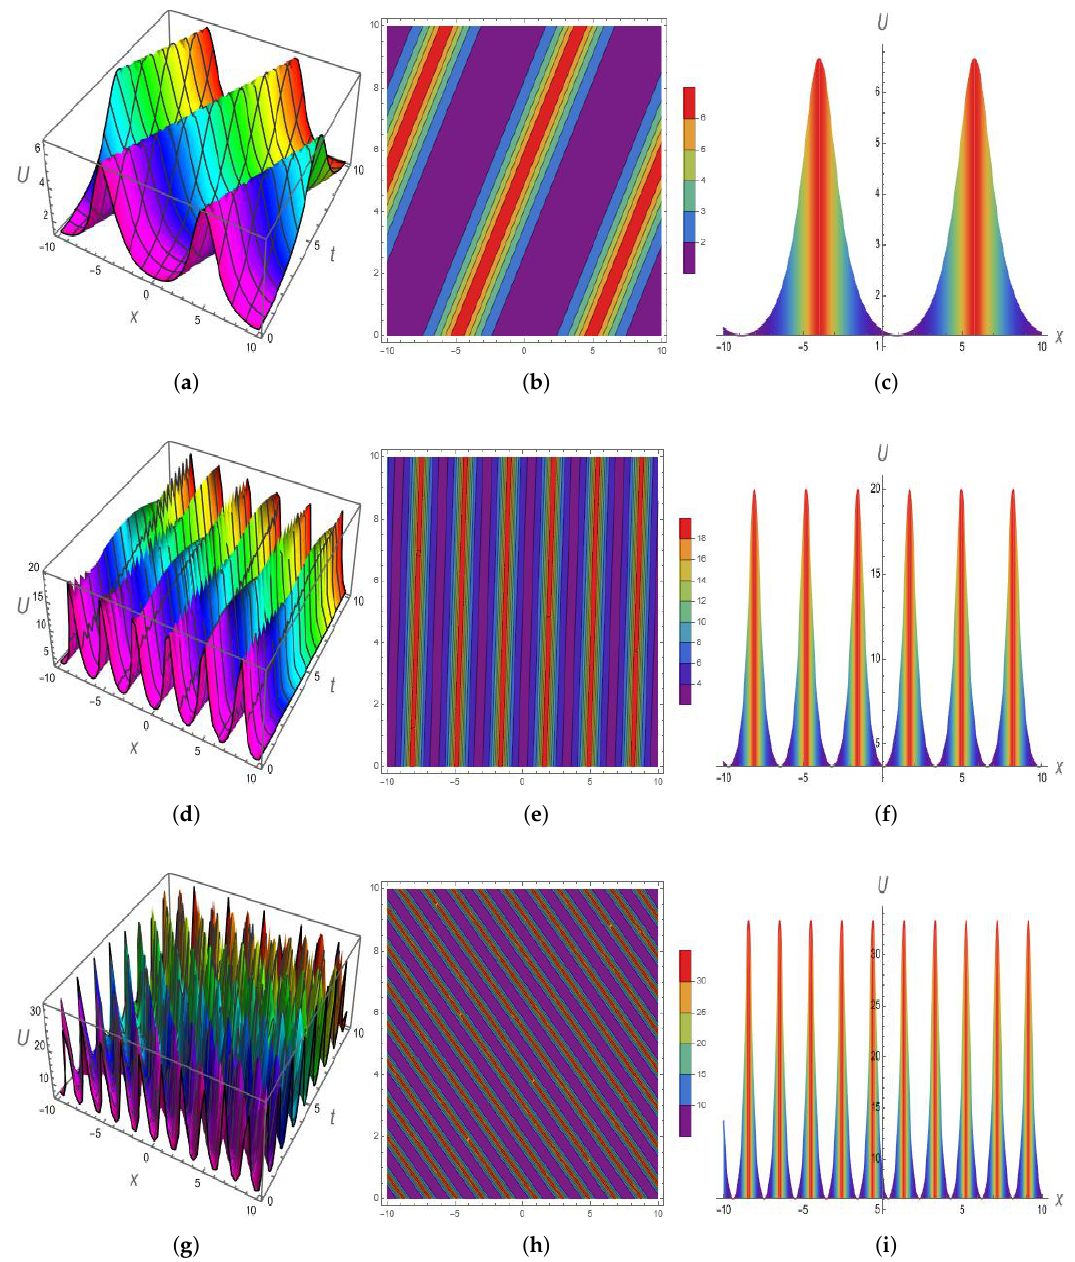
Figure 4. Three-dimensional, contour, and 2-D profiles for the imaginary part of solution £ 3 for different values of parameter k . ( a ) Three-dimensional propagation at k = 0.1; ( b ) Contour propaga- tion at k = 0.1; ( c ) Two-dimensional propagation at k = 0.1; ( d ) Three-dimensional propagation at k = 0.3; ( e ) Contour propagation at k = 0.3; ( f ) Two-dimensional propagation at k = 0.3; ( g ) Three- dimensional propagation at k = 0.5; ( h ) Contour propagation at k = 0.5; ( i ) Two-dimensional propagation at k =